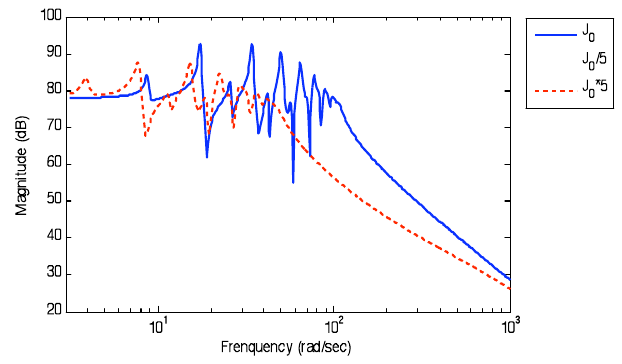
Fig. 6. Bode diagram of for different roll